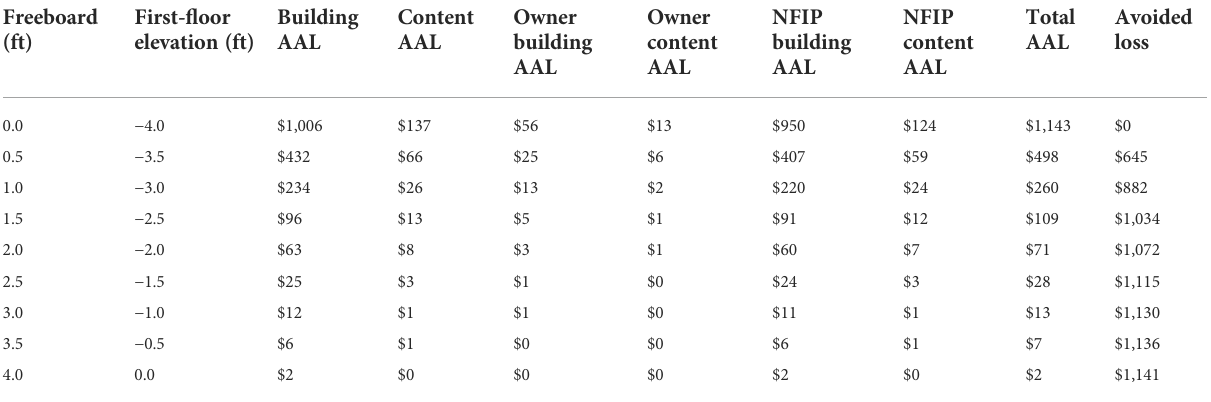
TABLE 4 AAL results for each freeboard height